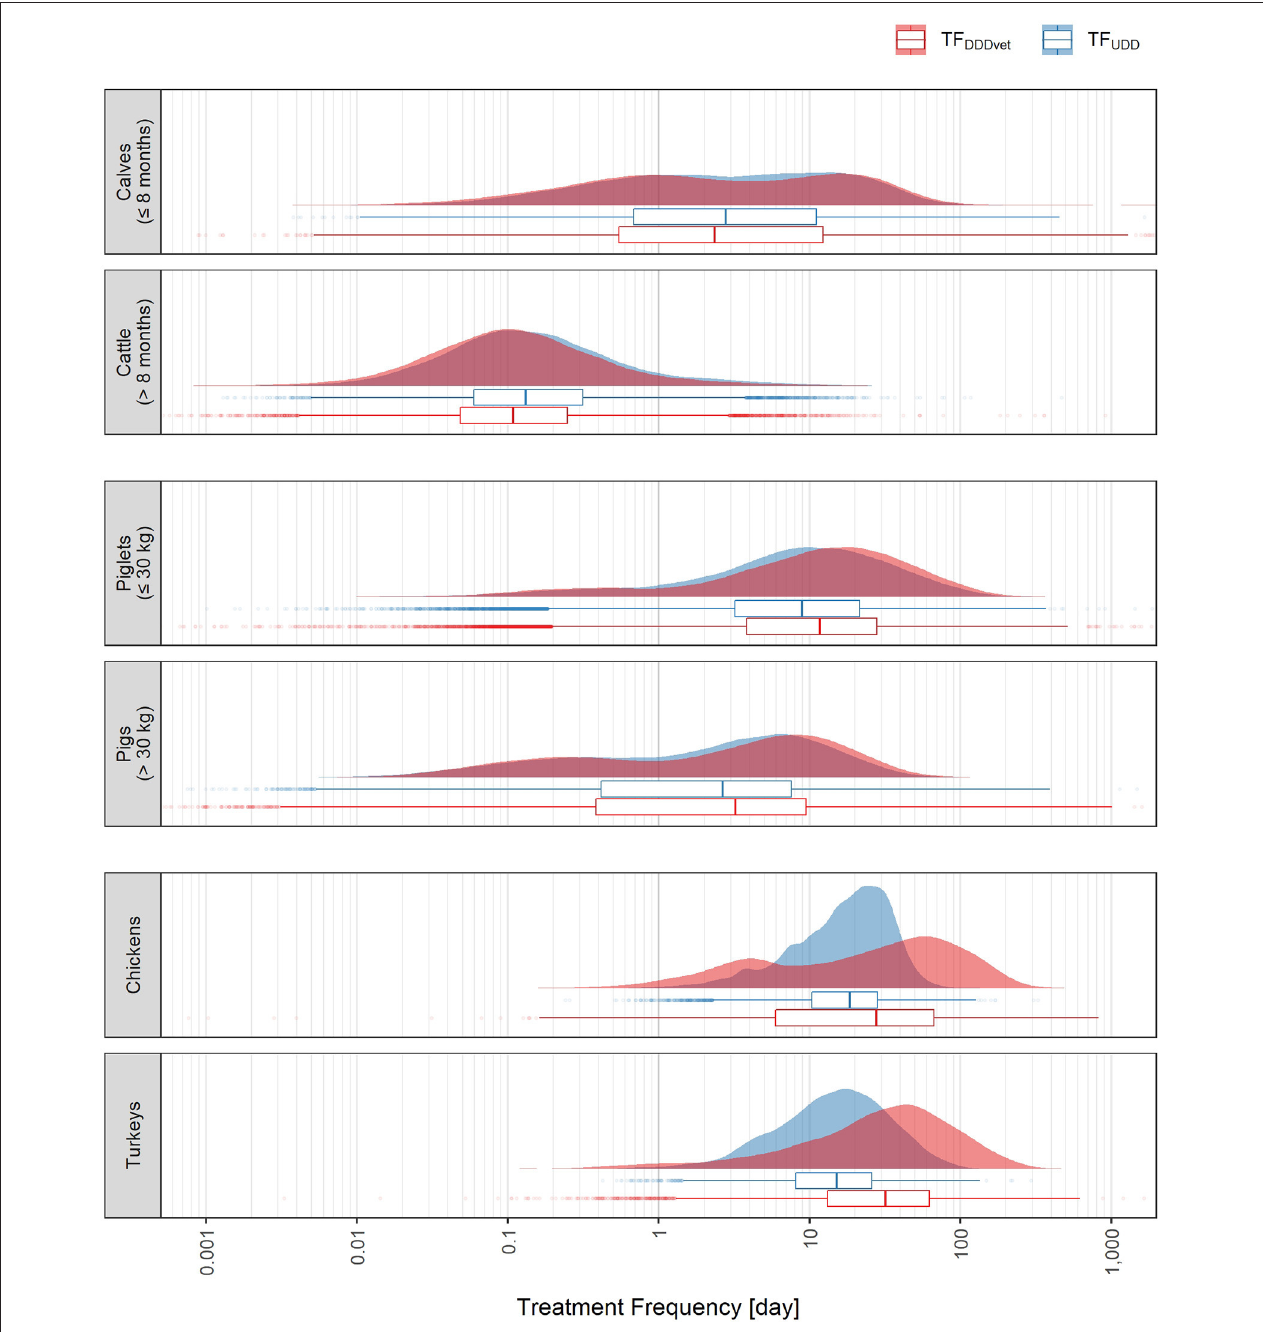
FIGURE 3 | Distributions of UDD-based treatment frequencies, TF UDD (blue), and DDDvet-based treatment frequencies, TF DDDvet (red), for each of the six animal populations covered by the German benchmarking system. The abscissa is log-scaled. Data is from all half-year periods 2014-2 to 2017-2.